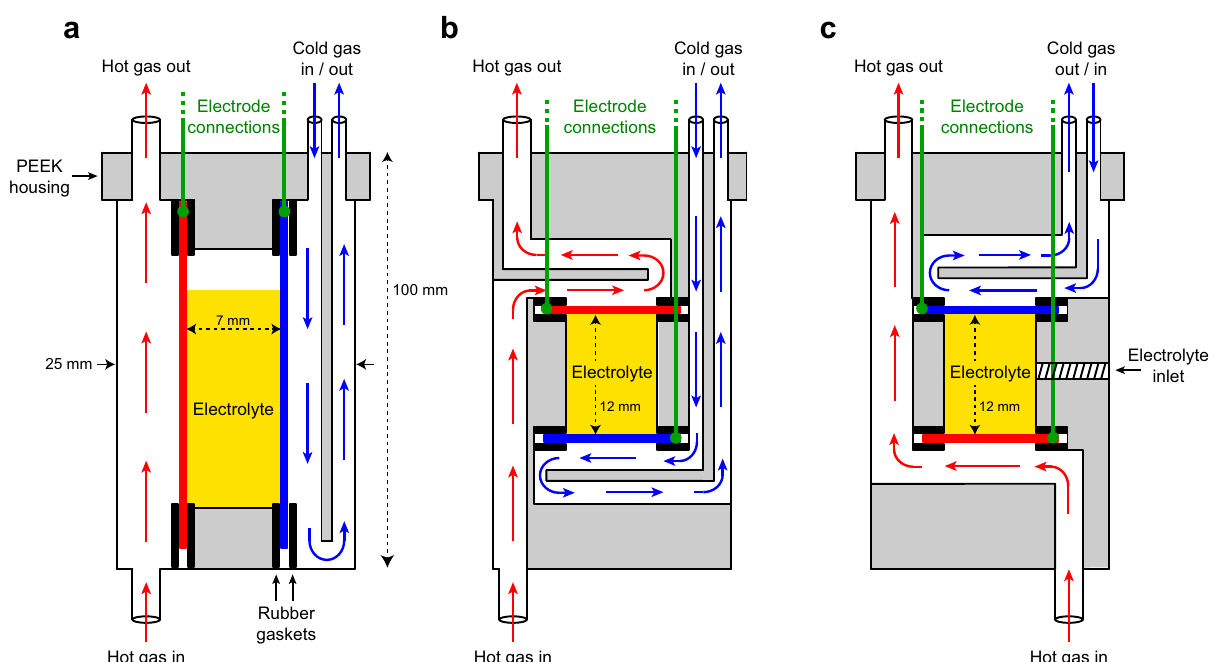
Fig. 1 Schematics of the thermocell designs for operando MRI experiments. a Vertical, b horizontal hot-above-cold and c cold-above-hot electrode orientations. Red and blue arrows represent hot and cold gas fl ow pathways, respectively. Additional illustrations of the cells are provided in the Supplementary Information, and full design details are available upon Fig. 2d and e, respectively. The protons of the bipyridyl ligands